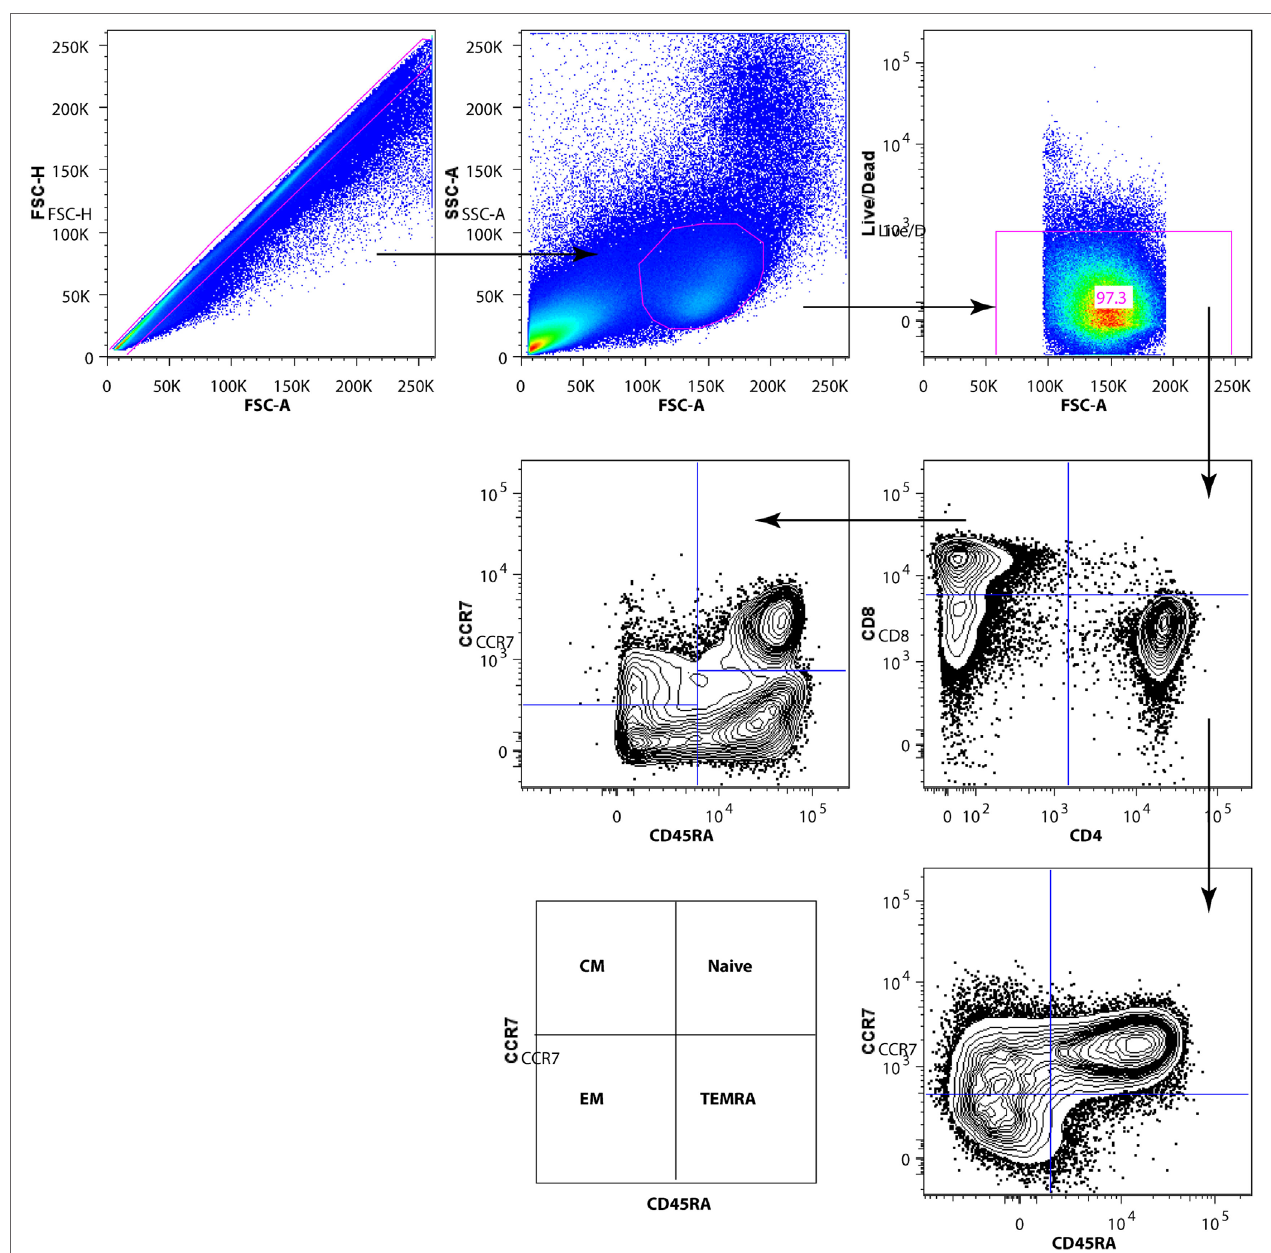
FigUre 2 | Gating strategy for subpopulations of CD4 + and CD8 + T cells. After exclusion of dead cells and doublets, total T cells were identified by CD3 surface expression. Gated CD3 + T cells were divided into CD4 + and CD8 + T-cell subsets. The CD4 + and CD8 + T-cell subpopulations [naive, EM, CM, TEMRA] were identified by CD45RA and CCR7 expression.